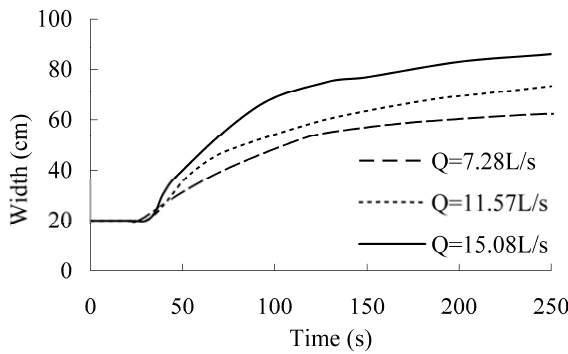
Fig. 11Relationship between the break width changing process and the total discharge.